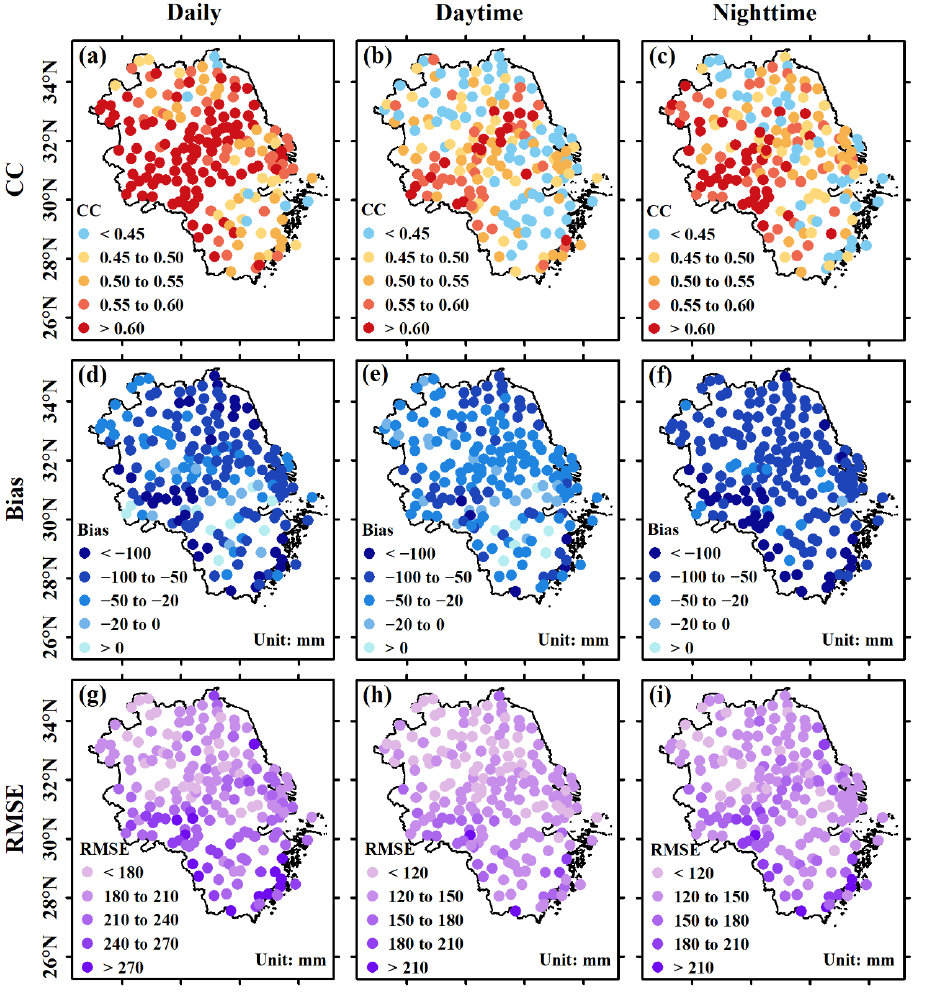
Figure 8. Correlation coefficient (CC) ( a – c ), Bias ( d – f ), and RMSE ( g – i ) between the yearly time series of precipitation amount data of stations and their corresponding ERA5 grid points at the daily, daytime, and nighttime scales (left, middle, and right panels, respectively) for the period 1961–2018 in the YRD.